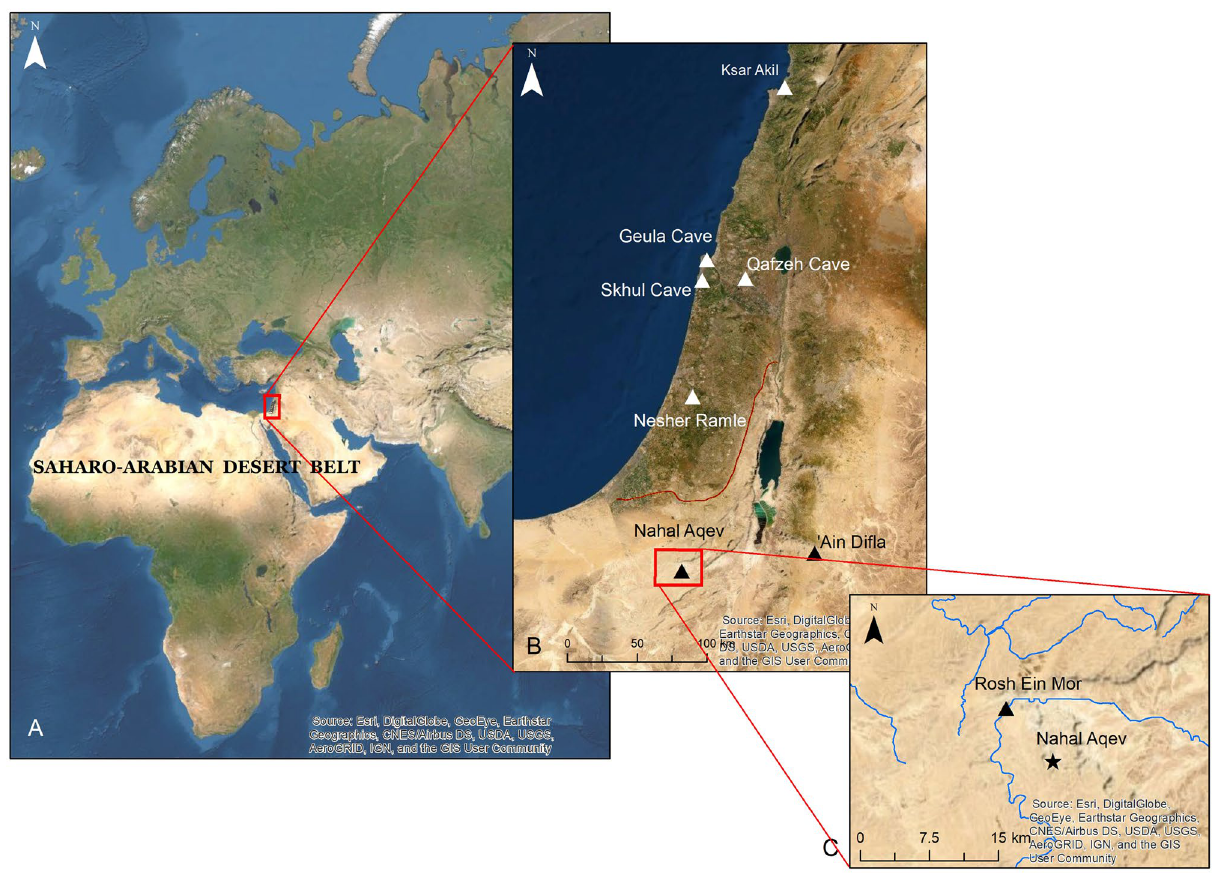
Figure 1. Location of Nahal Aqev and the Negev desert. ( A ) The Saharo-Arabian desert belt. ( B ) Middle Paleolithic sites dated to MIS 5 in the Levant. Note the boundary between the Mediterranean woodland and the Negev desert (orange line). ( C ) The location on Nahal Aqev within the central Negev. All rights reserved to IAA GIS-research lab. Base maps provided by ESRI online database. Figure 1 was prepared by M. Birkenfeld (Israel Antiquities Authority,